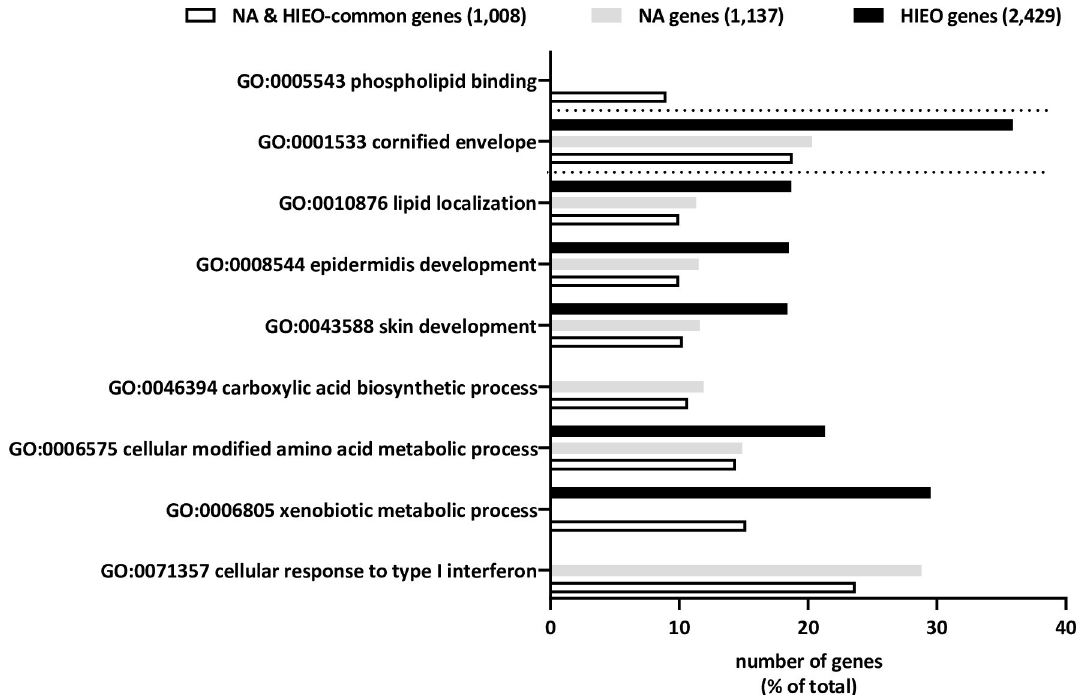
Fig 2. The top enriched GO terms. The GO terms were obtained from pathway enrichment analysis of differentially expressed genes (fold changes � 2 or � -2, Benjamini-Yekutieli corrected p-values to take care of multiple GO term testing � 0.05). Those significantly associated (P � 0.05) with the gene list are plotted with the number of genes (as a percentage of the list total) represented by bars, modulated by each treatment. Some terms were excluded as being redundant or having wide meaning (S4 Table).